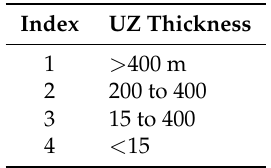
Table 2. Unsaturated zone thickness and corresponding